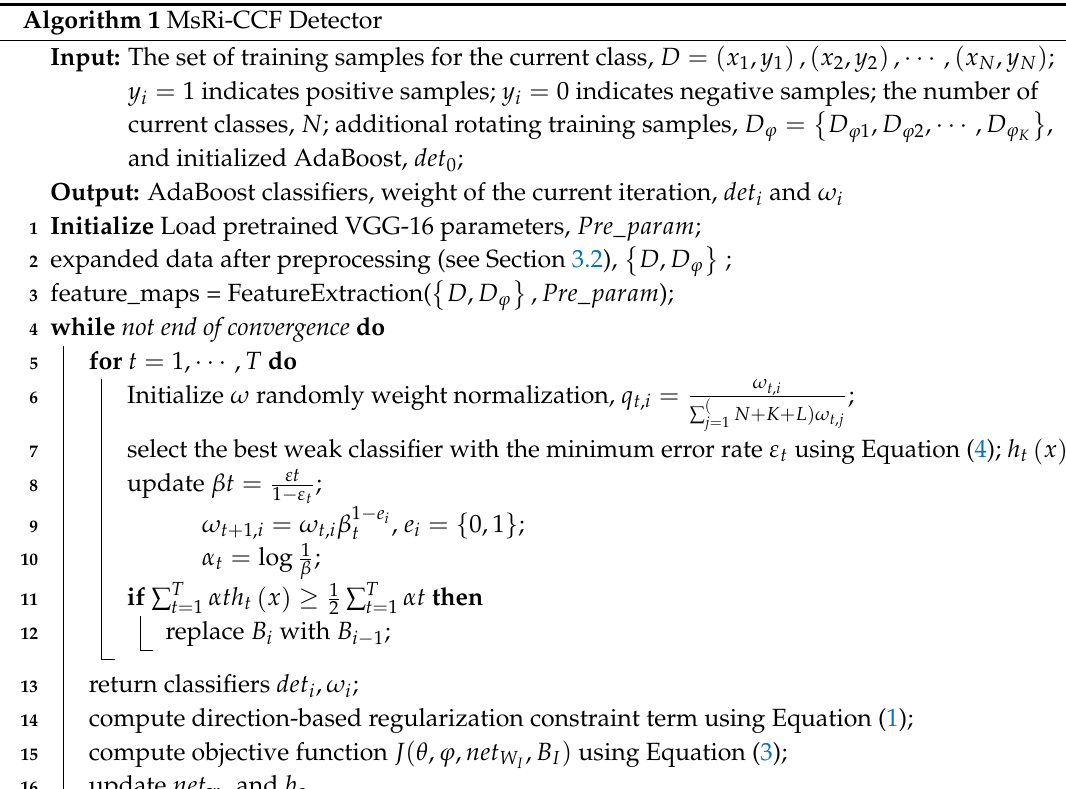
Algorithm 1 MsRi-CCF